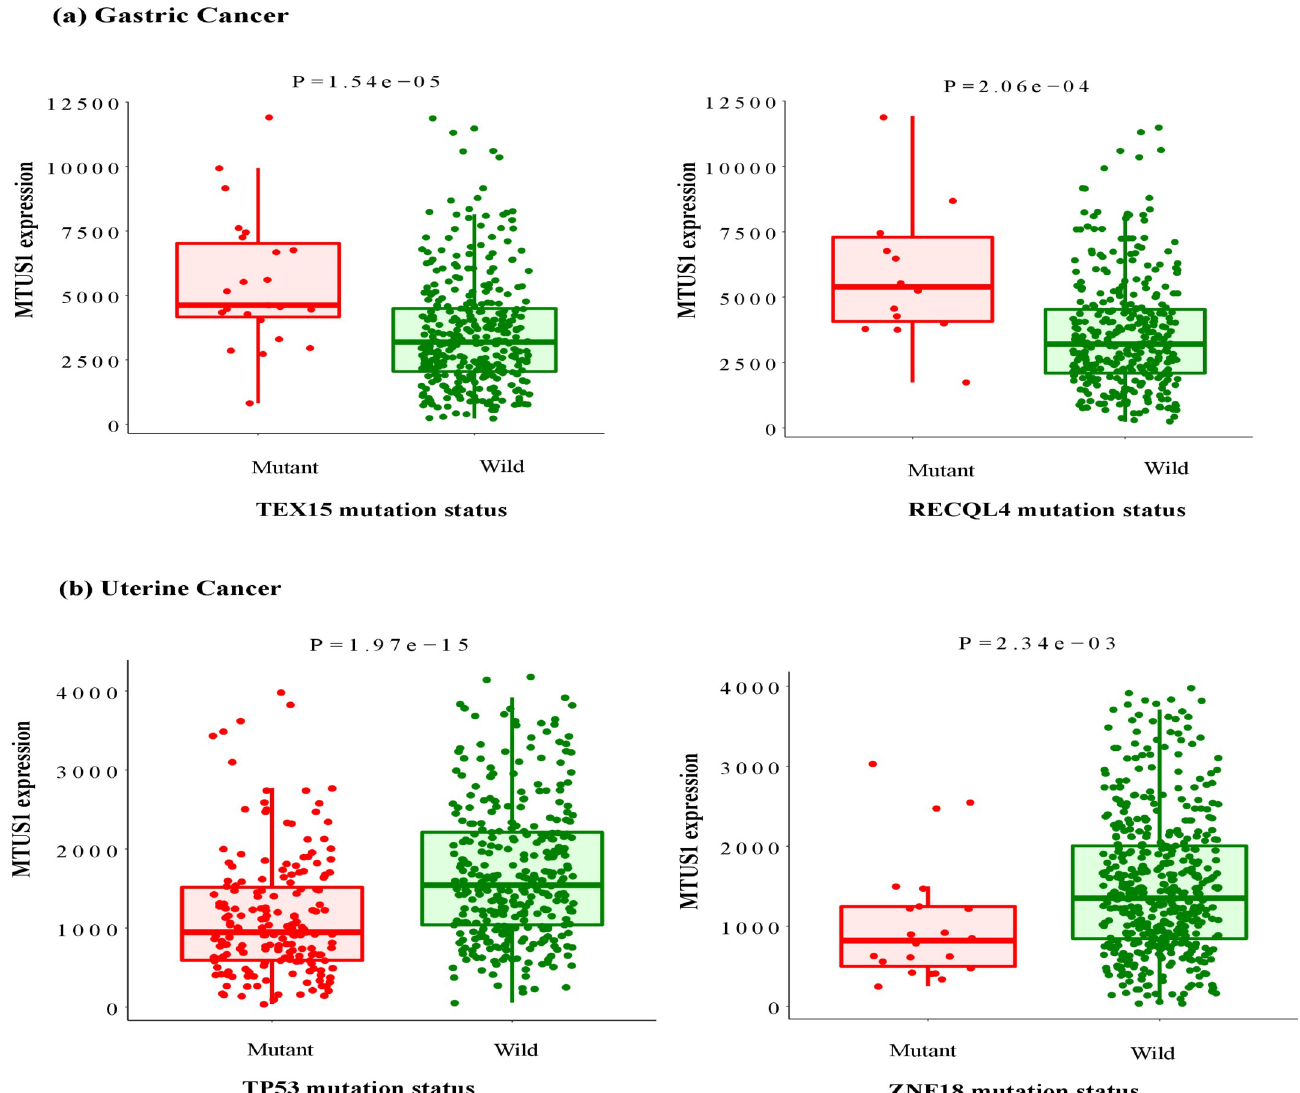
Fig 9. Target run for mutation in significant genes that alter the MTUS1 expression; (a) Gastric Cancer (b) Uterine cancer.